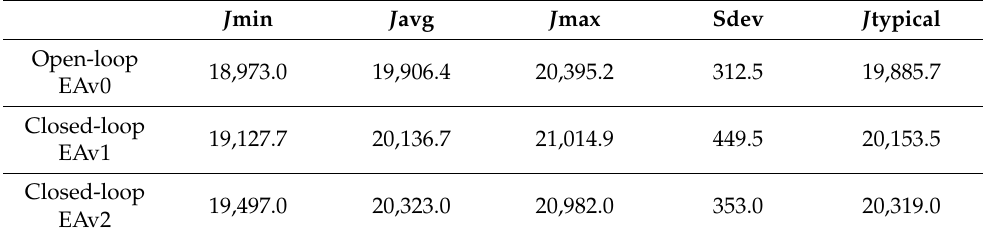
Table 10. Performance indexes recorded within the simulation